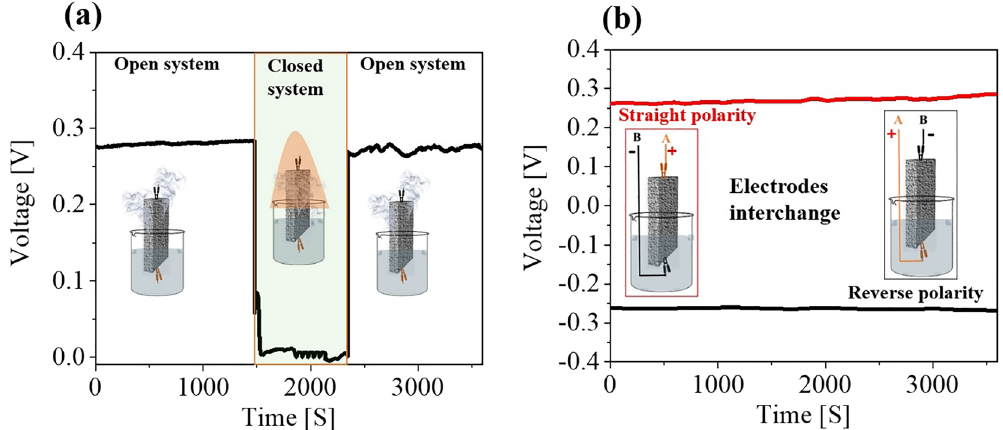
Figure 3. ( a ) Voltage signal in open and closed system with schematic representations. ( b ) Effect of electrodes interchange on induced voltage with sample setup schematics.